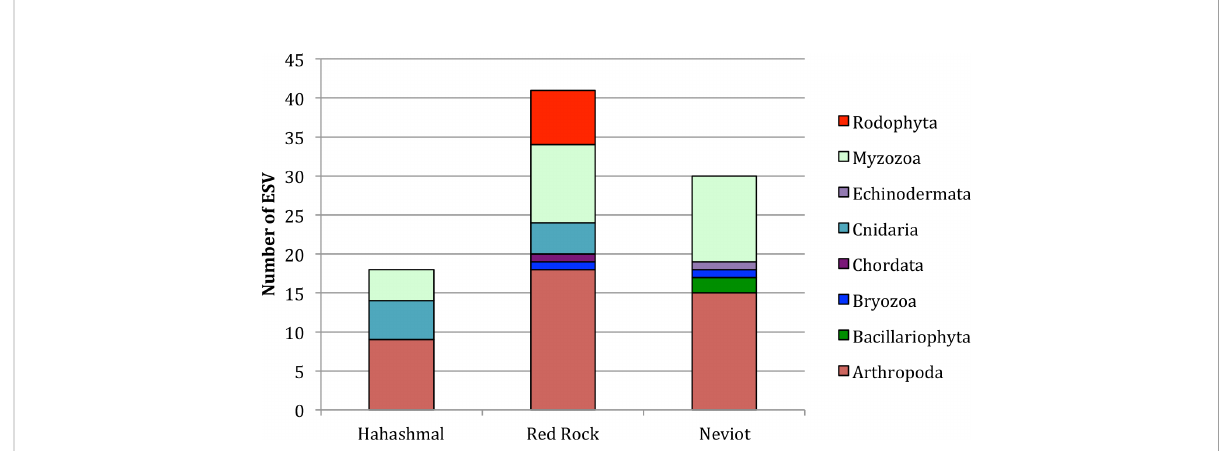
FIGURE 2 Taxonomic pro fi le of the analyzed samples. Results are presented as the number of ESV (putative species) of different phyla in each